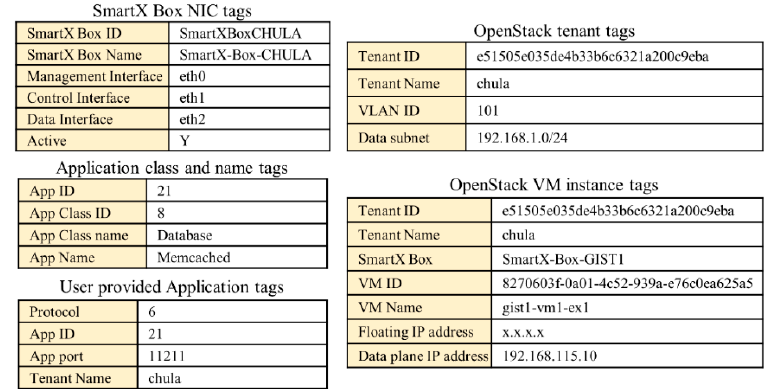
Figure 5 . Automatically acquired SmartX tags from the playground tower and playground users. Figure 5. Automatically acquired SmartX tags from the playground tower and playground